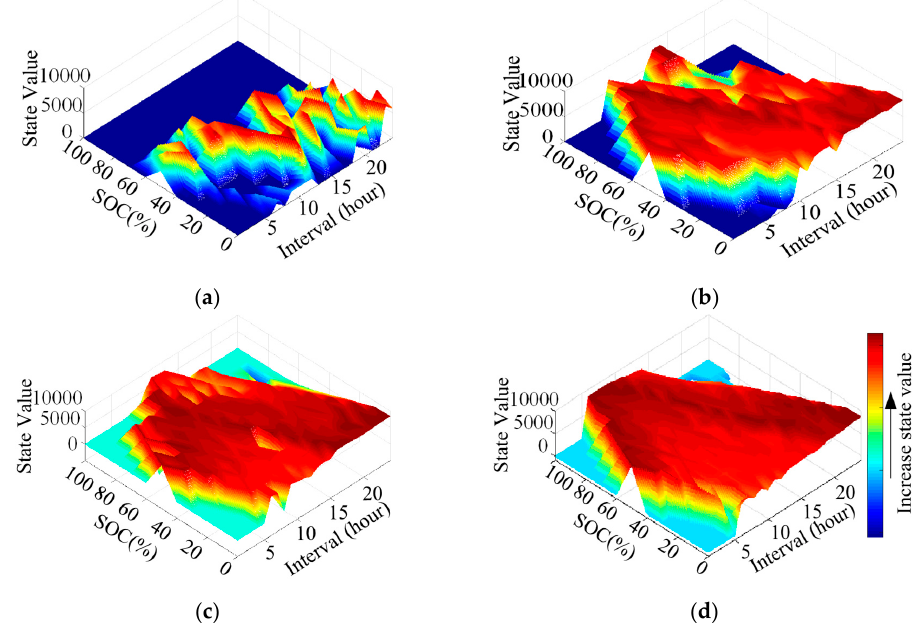
Figure 7. The state-action values (Q values) of community battery storage (CBES) with different number of episodes: ( a ) 10 episodes; ( b ) 1000 episodes; ( c ) 10,000 episodes; ( d ) 50,000 episodes.